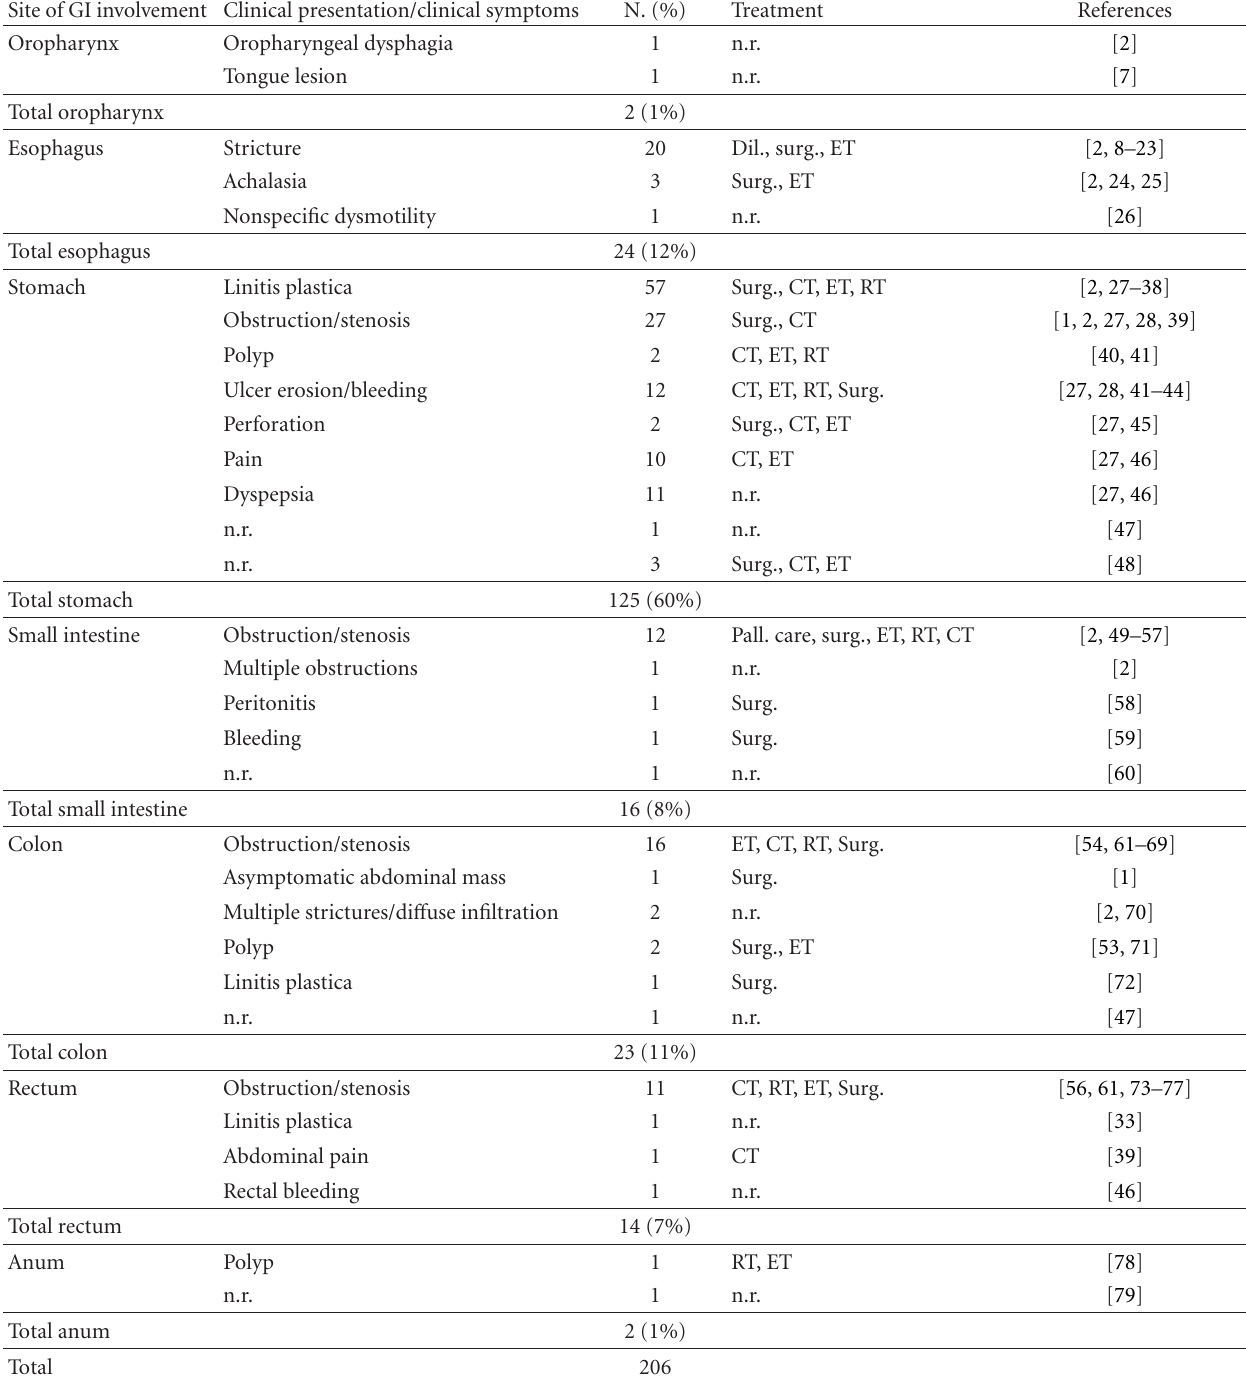
Table 2: Results from reviewing of the literature: patients with breast cancer and GI involvement. Site of GI involvement Clinical presentation/clinical